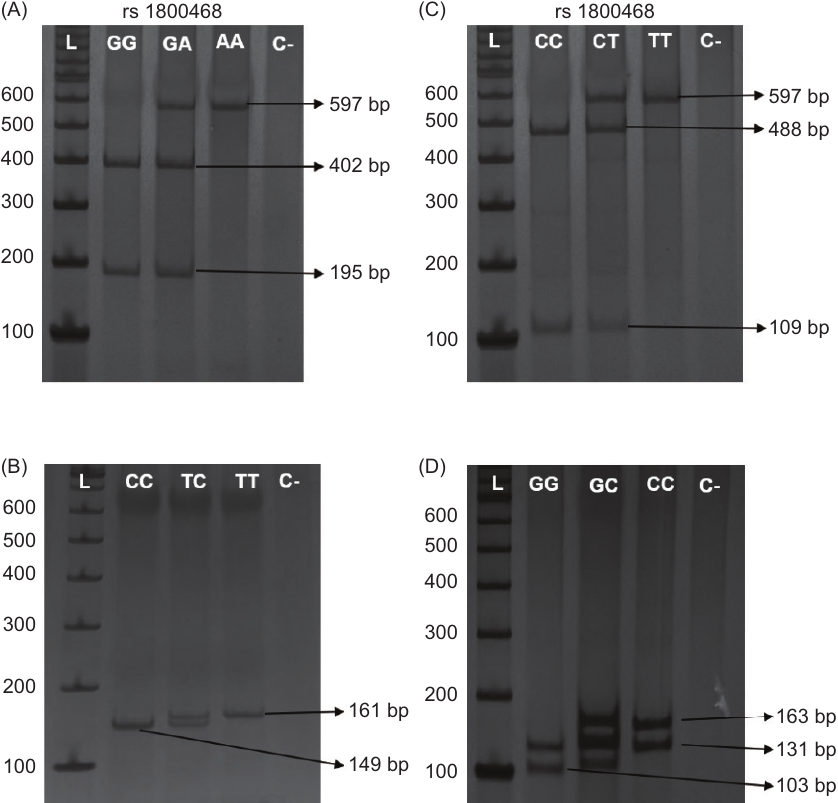
Figure 1: Promoter and signal peptide regions of TGFB1 genetic polymorphisms profile. Electrophoretic profile of: (A) rs1800468 (G-800A), (B) rs1800469 (C-509T), (C) rs1800470 (c.29C>T), and (D) rs1800471 (c.74G>C). The PCR products after restric- tion digestion were analyzed by electrophoresis on acrylamide gel (10%), detected by silver staining method. L: Ladder 100 bp; C: negative